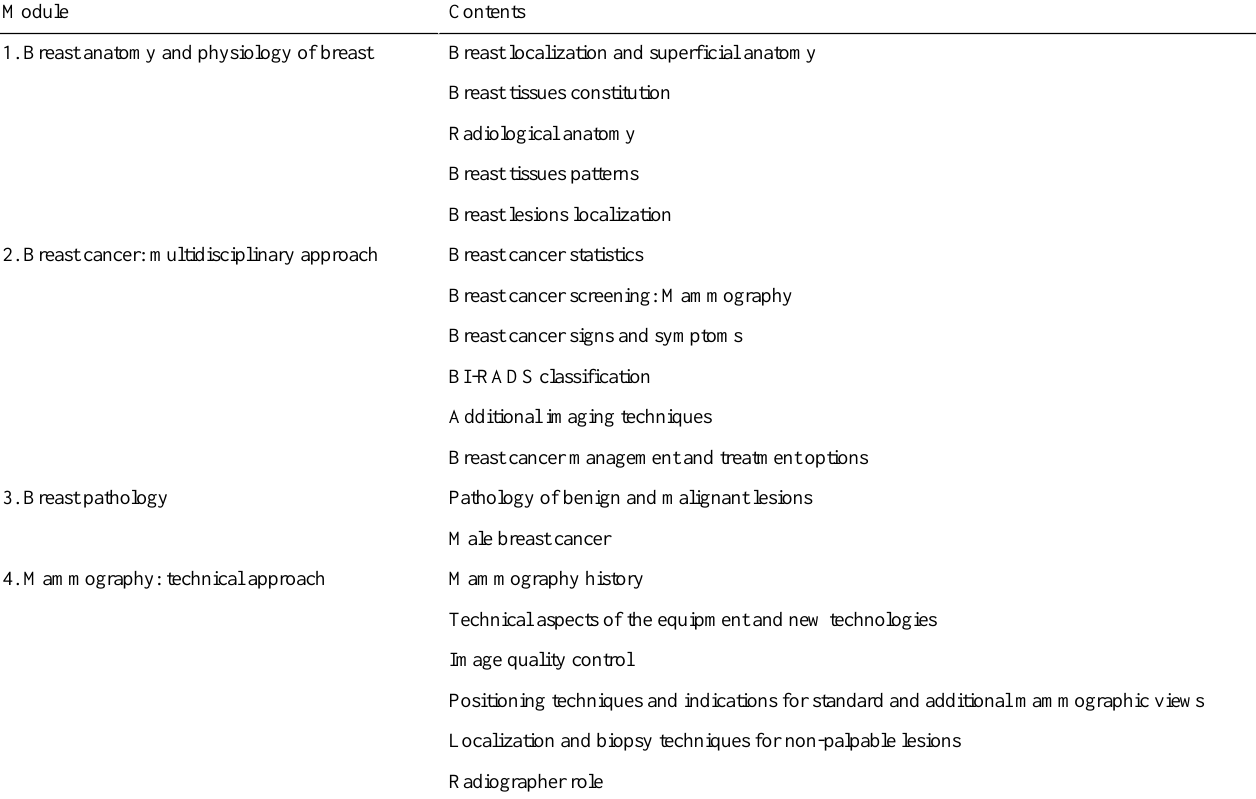
Table 1. Description of the main contents included in the intervention e-learning